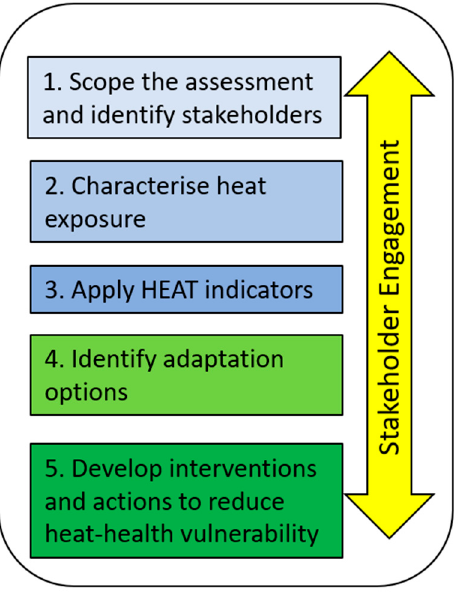
Figure 2. The steps we followed in an inclusive assessment of health vulnerability to heat